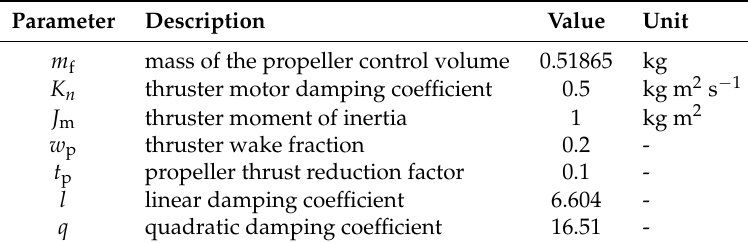
Table A2. Propulsion system parameters taken from [24].